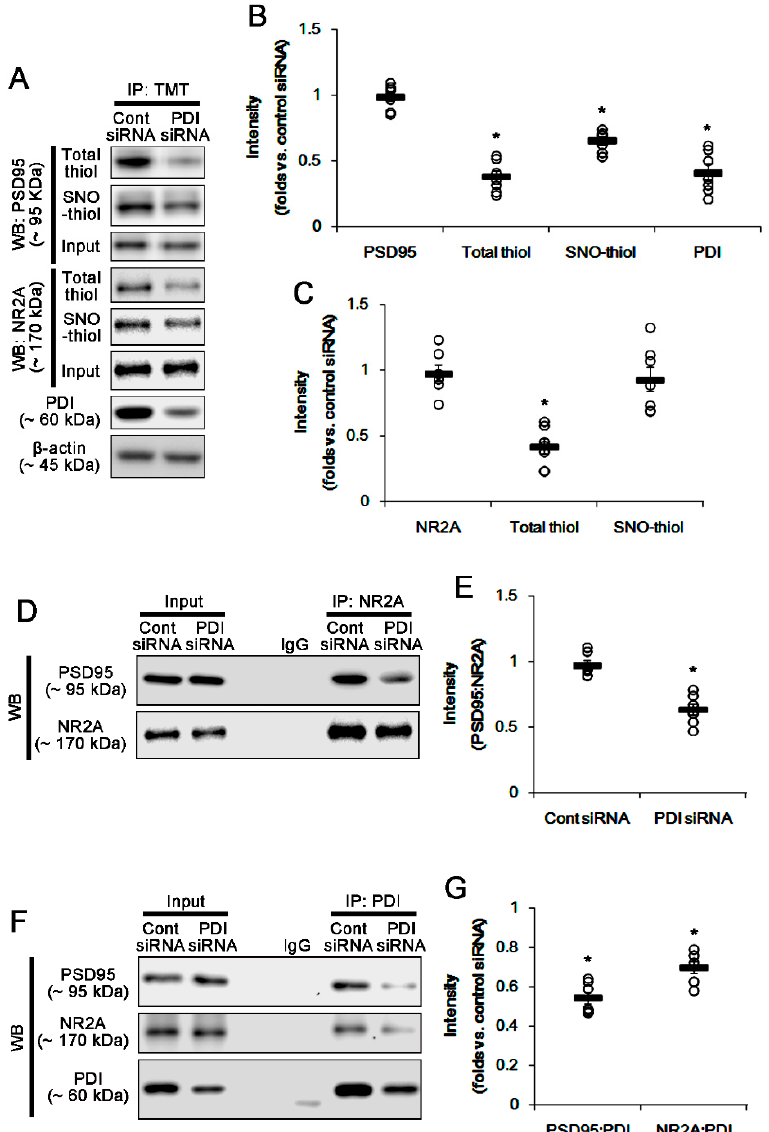
Figure 6. E ff ects of PDI knockdown on the amounts of total- and SNO-thiols on PSD95 and NR2A, and the bindings of NR2A–PSD95, PDI–PSD95 and PDI–NR2A in the hippocampus of epilepsy rats. ( A ) Representative Western blot for expression and the amounts of total- and SNO-thiols on PSD95. As compared to control siRNA, PDI siRNA reduces PDI protein level and the total thiol level on PSD95, without altering PSD95 expression. PDI siRNA also e ff ectively decreases the total thiol level, but not SNO-thiol level, on NR2A in epilepsy rats. ( B , C ) Quantification of Western blot data. Open circles indicate each individual value. Horizontal bars indicate mean value. Error bars indicate SEM (* p < 0.05 vs. saline, Student’s t -test, n = 7, respectively). ( D ) Co-immunoprecipitation analysis of NR2A–PSD95 interaction in epileptic rats. The NR2A–PSD95 binding is significantly reduced by PDI knockdown. ( E ) Quantification of Western blot data. Open circles indicate each individual value. Horizontal bars indicate mean value. Error bars indicate SEM (* p < 0.05 vs. saline, Student’s t -test, n = 7, respectively). ( F ) Co-immunoprecipitation analyses of PDI–PSD95 and PDI–NR2A co-assemblies in epileptic rats. The PDI–PSD95 and PDI–NR2A bindings are diminished by PDI siRNA. ( G ) Quantification of Western blot data. Open circles indicate each individual value. Horizontal bars indicate mean value. Error bars indicate SEM (* p < 0.05 vs. saline, Student’s t -test, n = 7, respectively).